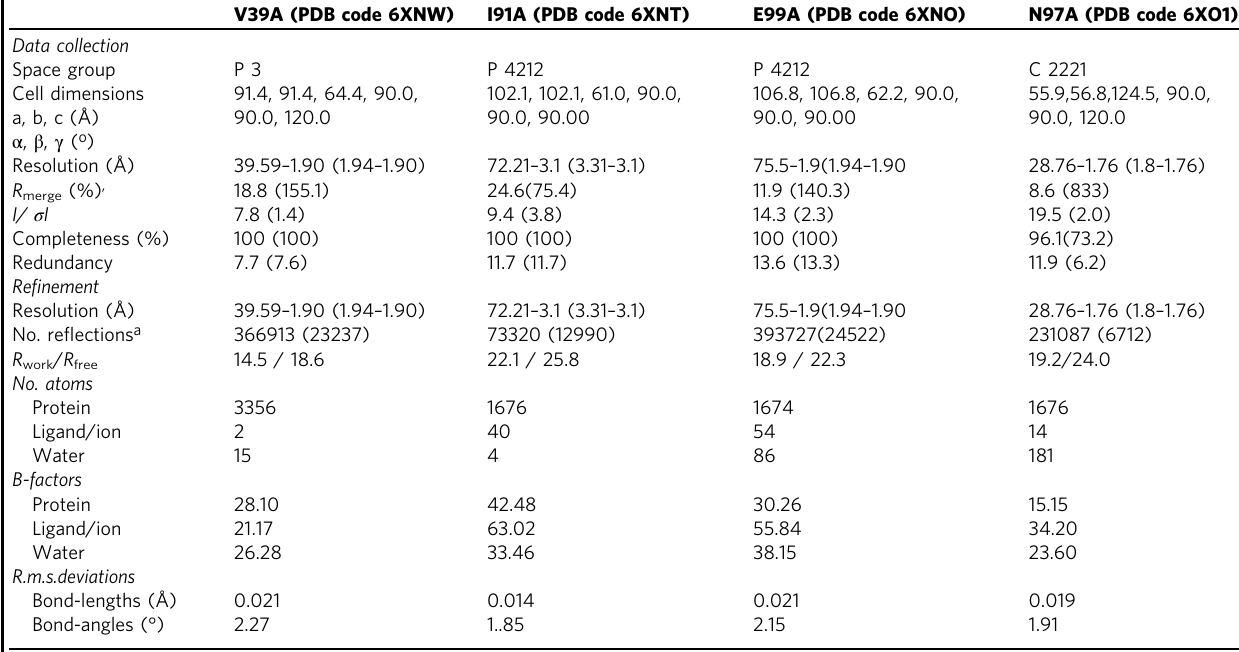
Table 1 Data collection and re fi nement statistics (molecular